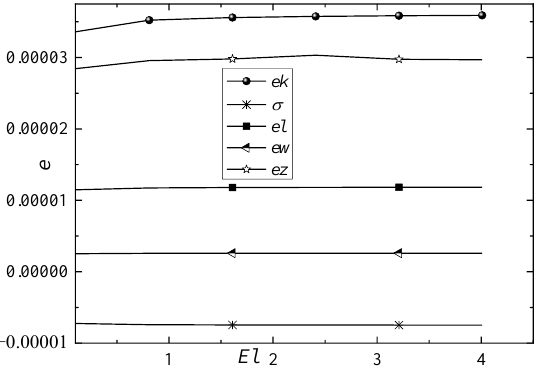
Figure 10. Effect of elasticity number E l on the rate of change in the kinetic energy and other forces.